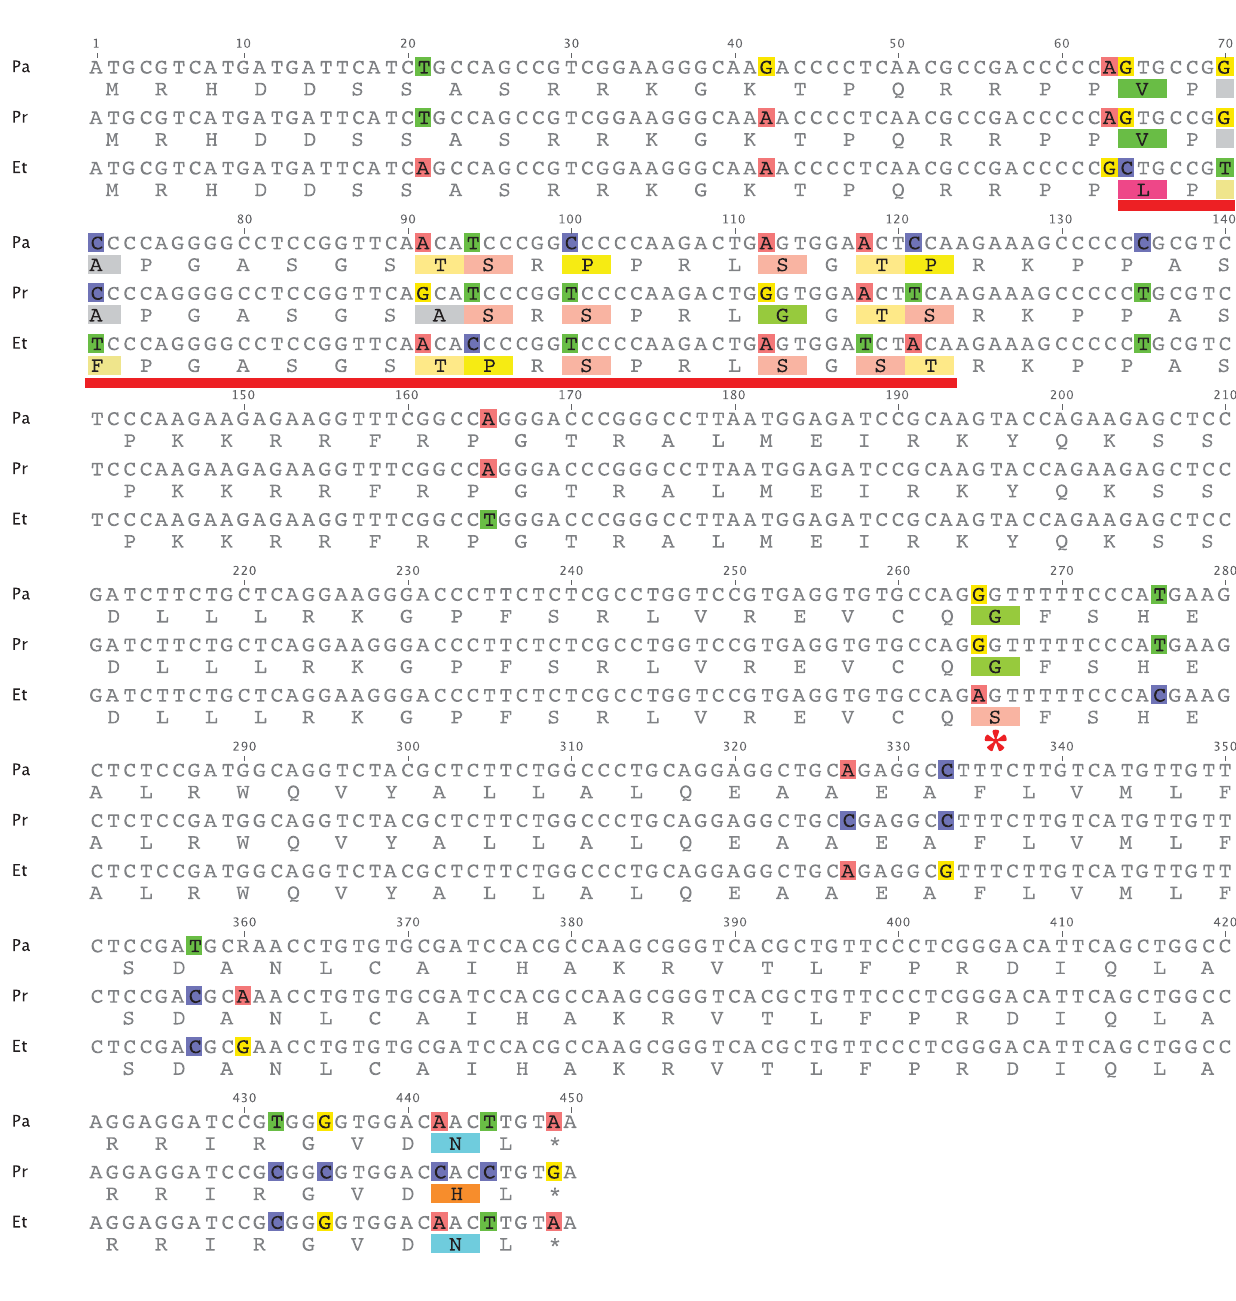
Figure 4. Comparative sequence analysis of CENP-A of P. austroperka (Pa), P. roanoka (Pr), and E. tallapoosae (Et). The red underline indicates a region within the N-terminal tail where K > K A S